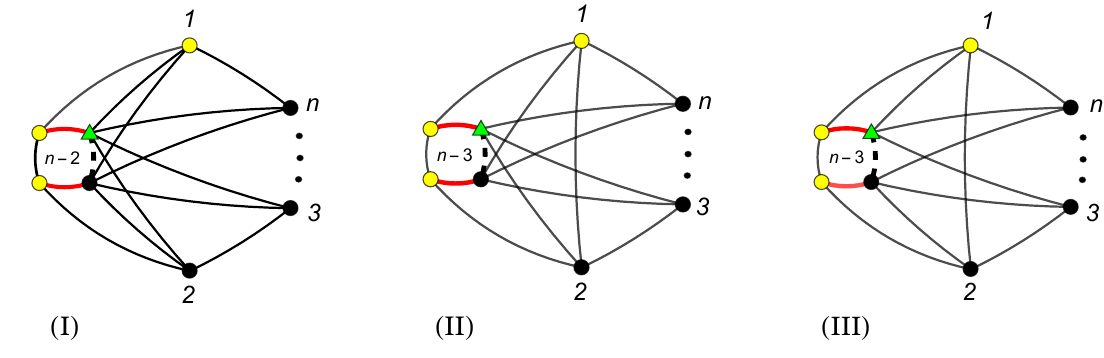
Figure 5 . Simplest cases of CHY-graphs from (cid:12)gure